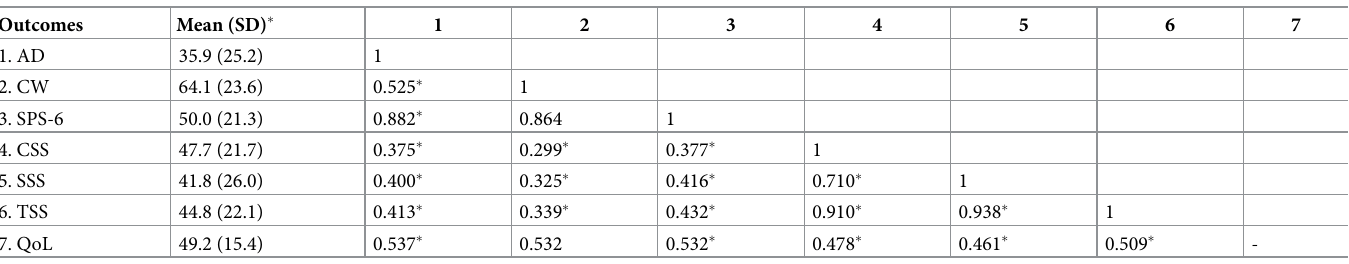
Table 2. Bivariate correlations and descriptive statistics of main study variables.